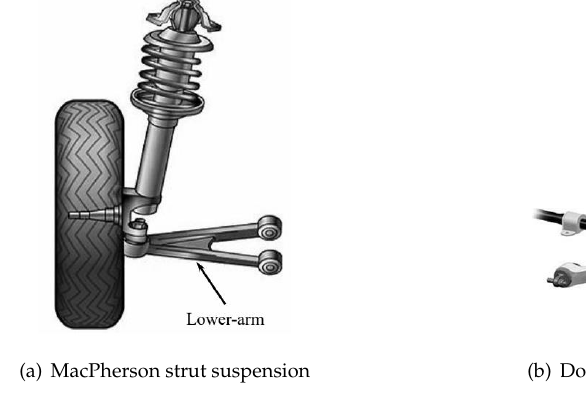
Figure 4. Fork-arm components in suspension